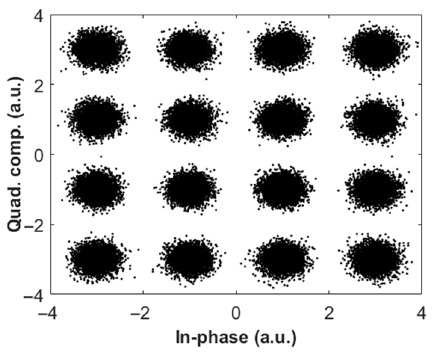
Figure 7. Example of received constellation diagram for QAM-16 in FSO KK system (downlink, K = 10).